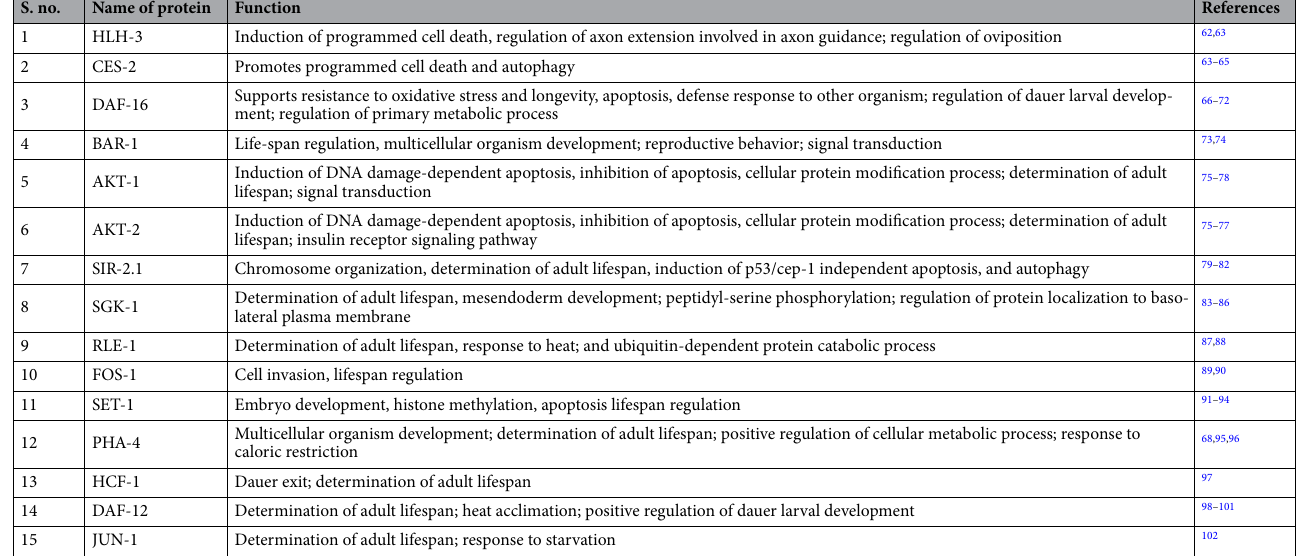
Table 4. C. elegans SIN-3 protein interactors involved in apoptosis, autophagy and longevity.